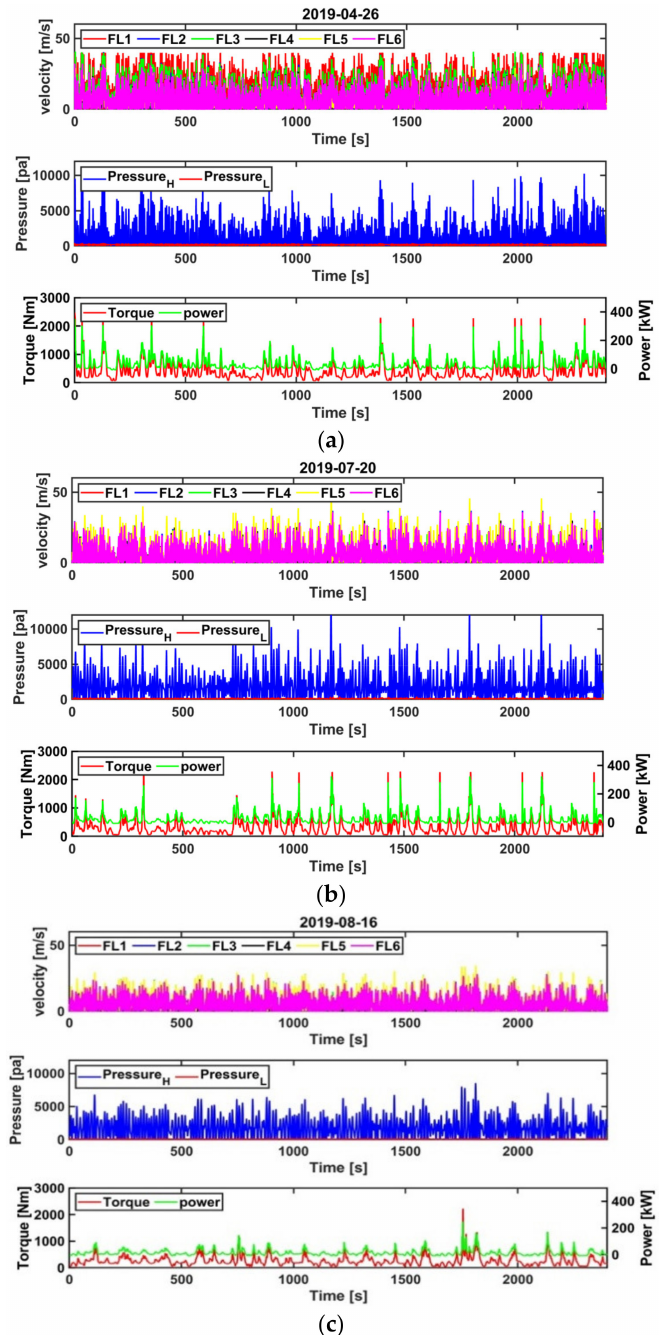
Figure 9. Training datasets for the application of deep learning algorithms: ( a ) 26 April 2019, ( b )